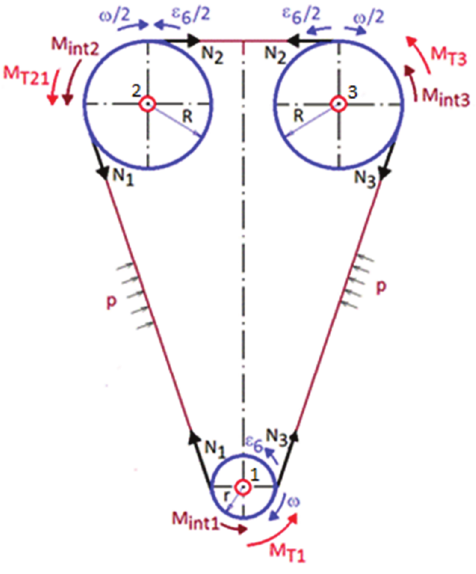
Fig. 3. The model of loading the chain transmission